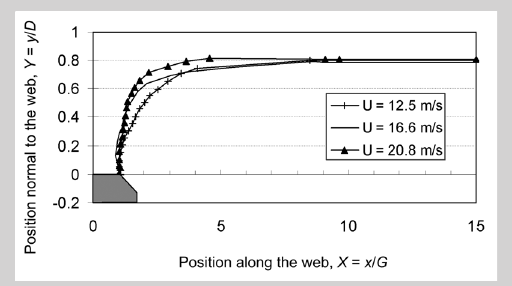
Figure 12: Downstream meniscus configuration for C65-0 at three different web